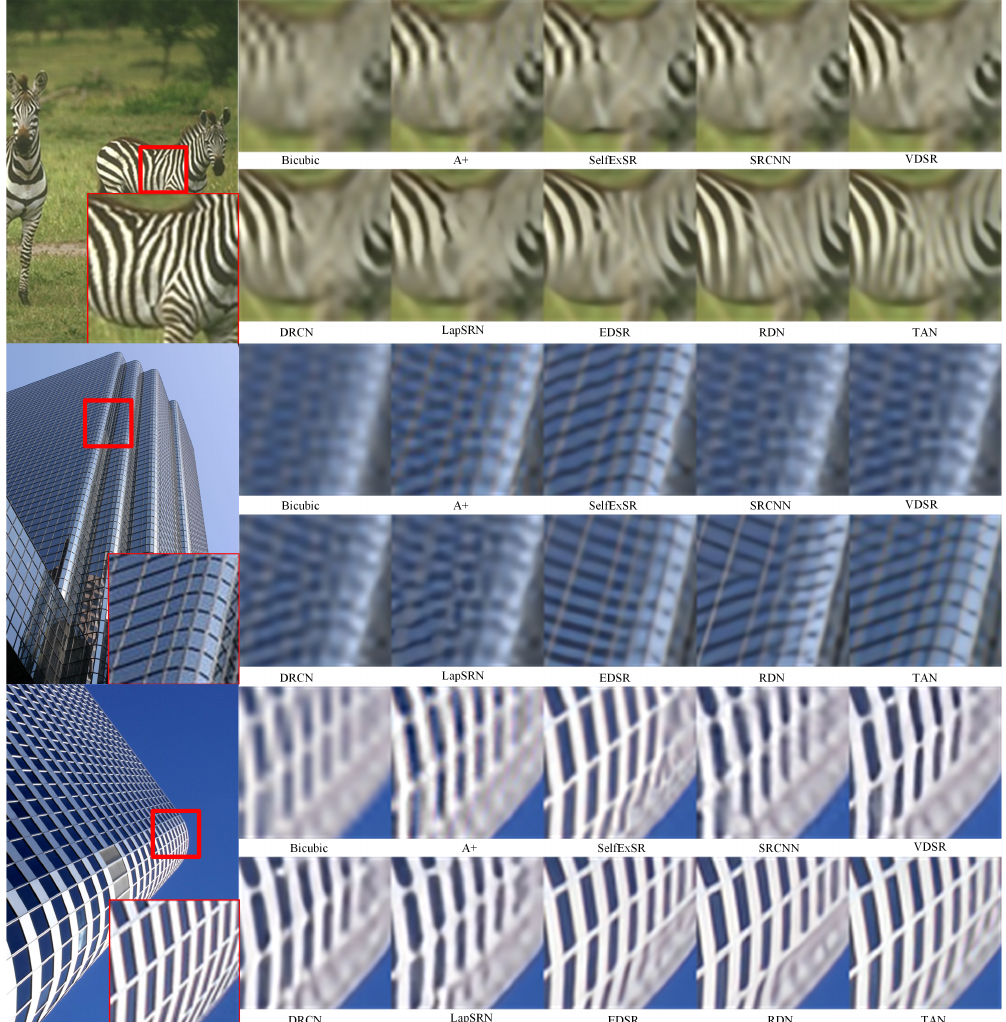
Figure 6. Visual comparison for details of reconstructed images. Compared with Bicubic, A+ [2], SelfExSR [12], SRCNN [3], VDSR [13], DRCN [14], LapSRN [5], EDSR [4] and RDN [7], our proposed TAN shows the best visual